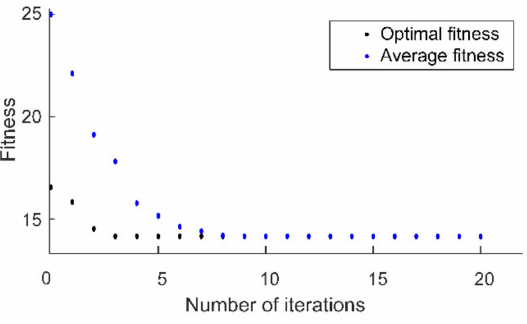
Figure 2. Optimization results of fitness.